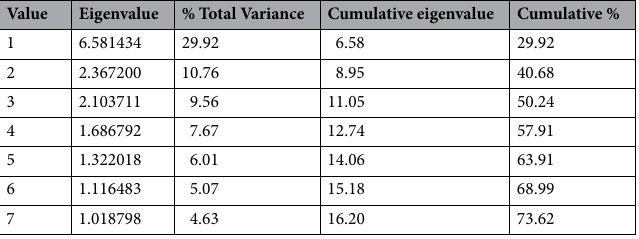
Table 4. Eigenvalues (Data Bank NUPEA 600 wells). Extraction: Principal Components.